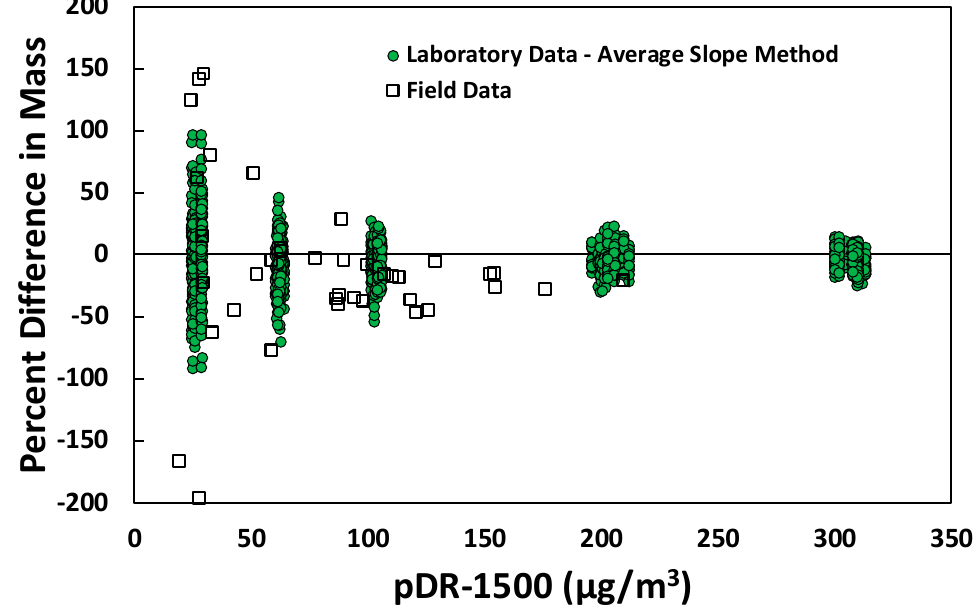
Figure 6. Comparison of percent difference observed in the laboratory to those observed in field tests based on 1-min averages.